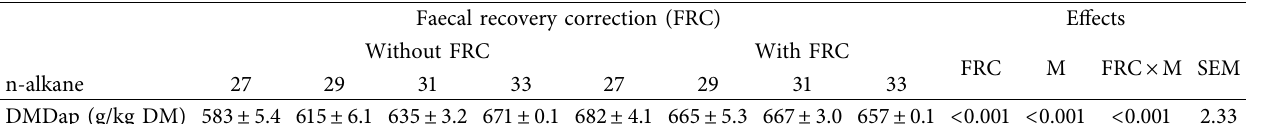
Table 4: Estimates of apparent dry matter digestibility (DMDap) in bison fed on straw and beeswax labelled concentrate feed, using different long-chain n